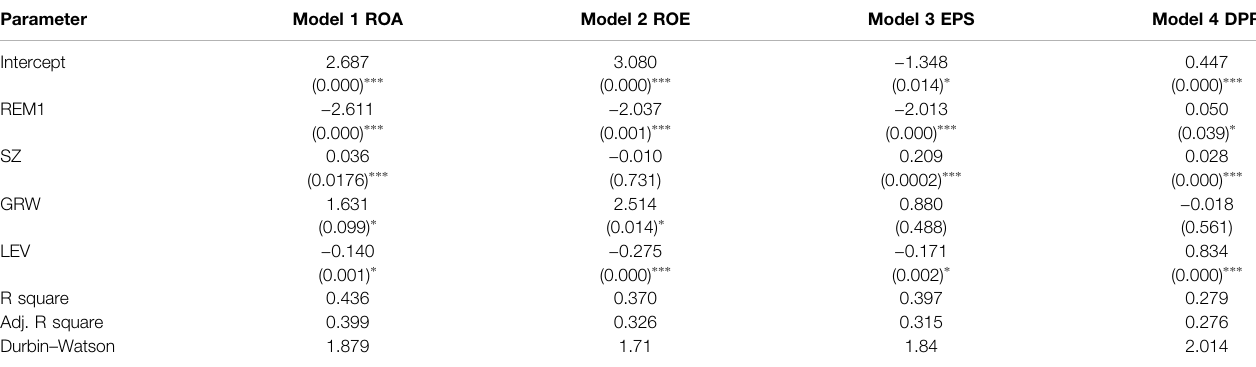
TABLE 3 | Results of regression analysis of REM on return and dividend payout. Parameter